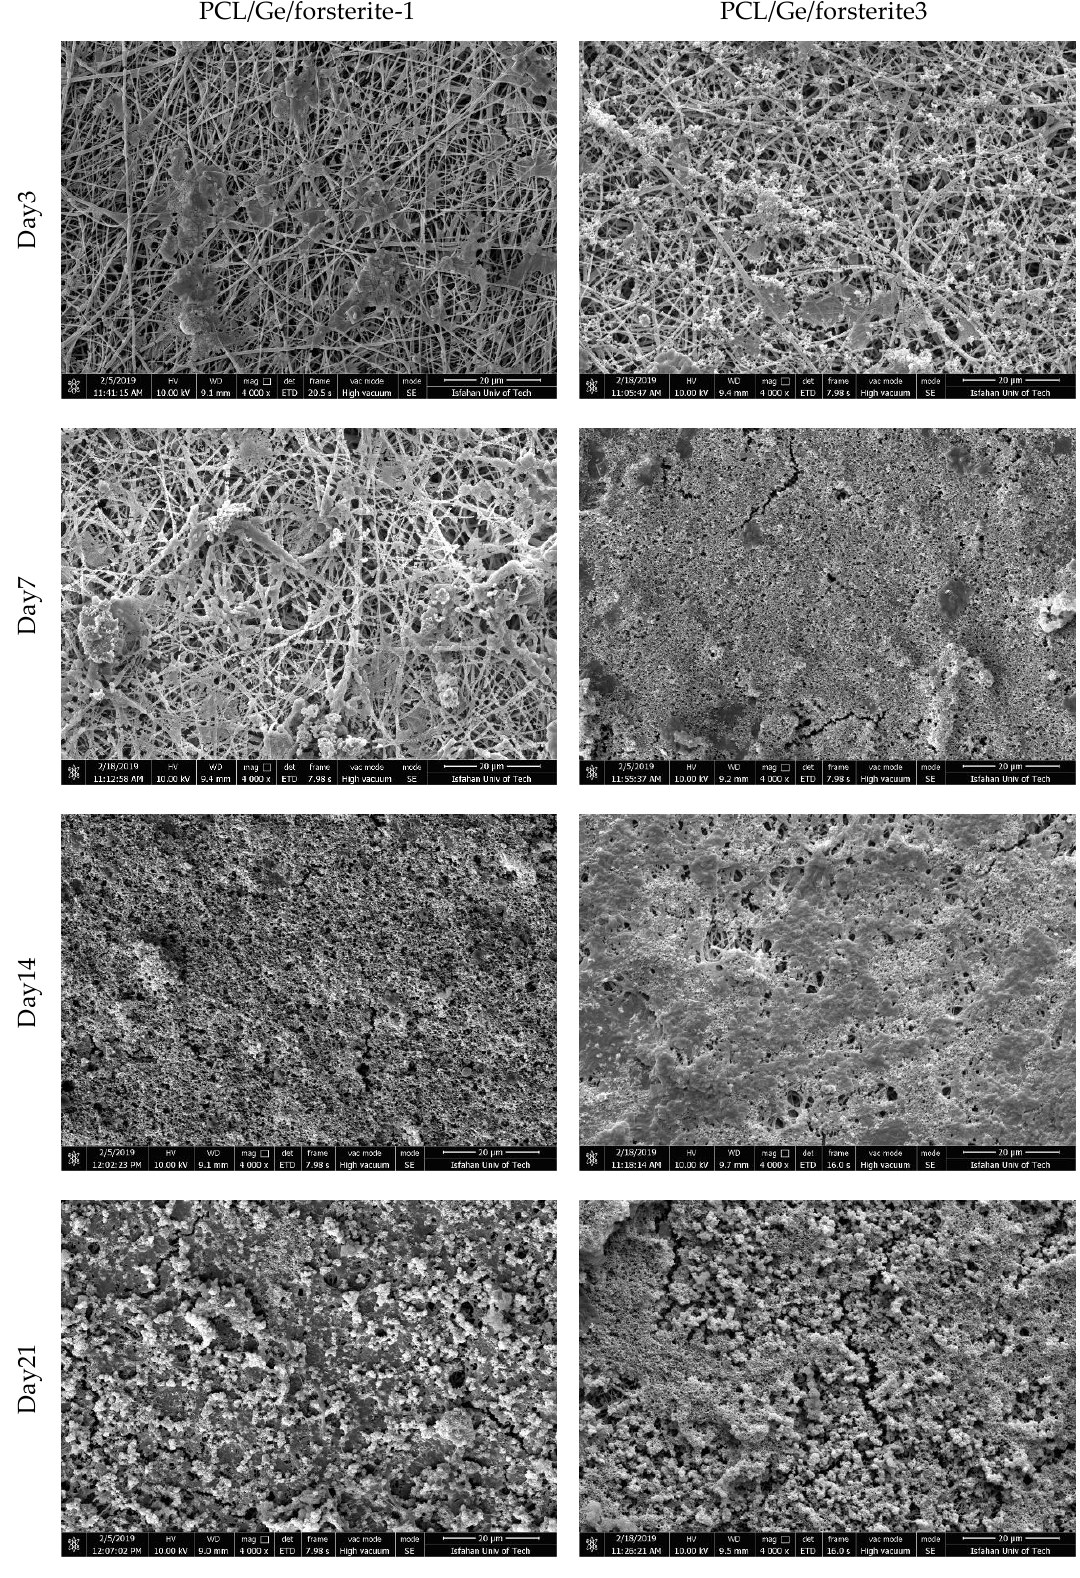
Figure 5. FESEM micrographs of the PCL / Ge / forsterite with 1 and 3 wt.% after 3, 7, 14, and 21 days immersion in the SBF solution.